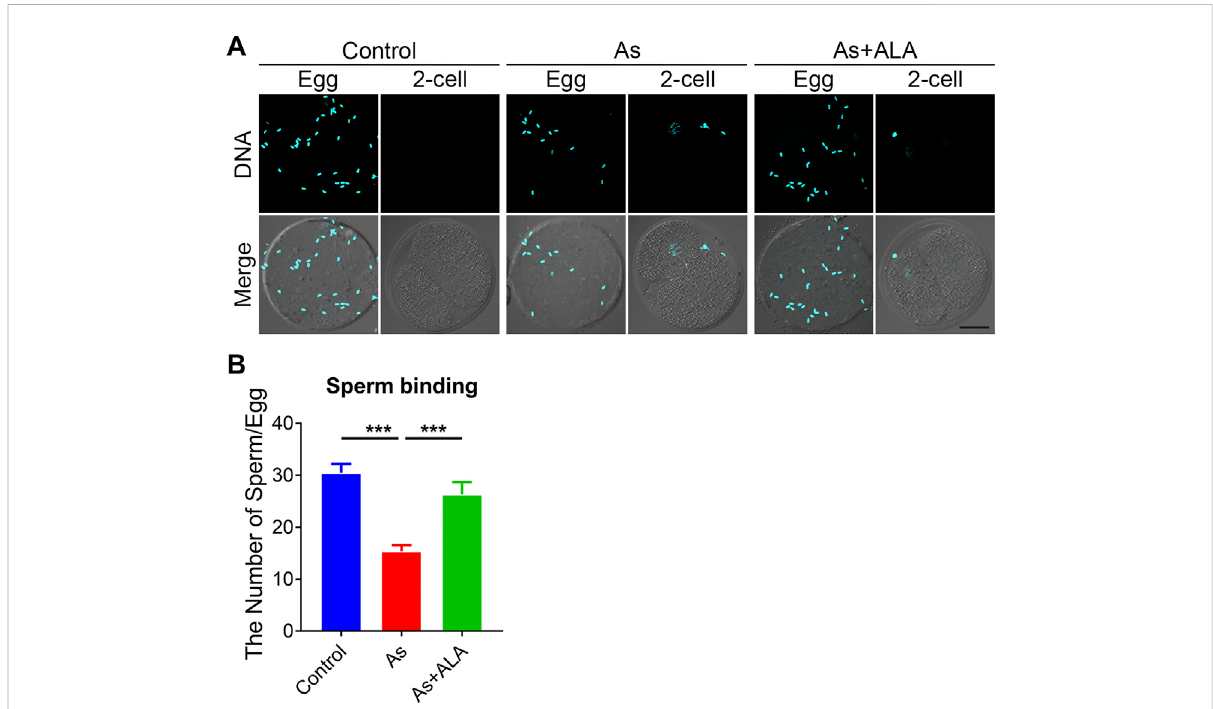
Effect of ALA supplementation sperm binding to the zona pellucida in arsenite-exposed oocytes. (A) Eggs and 2-cell embryos in control, arsenite-exposedandALA-supplementedgroupswereincubated(1 h)withcapacitatedsperm.Afterwashingwithawide-borepipettetoremoveall buttwoto sixsperm onnormal two-cell embryos(negative control), eggs andembryoswerestainedwith DAPI.Scale bar,30 µm. (B) Thenumberof sperms binding to the zona pellucida were calculated in control, arsenite-exposed and ALA-supplemented groups. Data were presented as mean percentage (mean ± SEM) of three independent experiments. *** p <